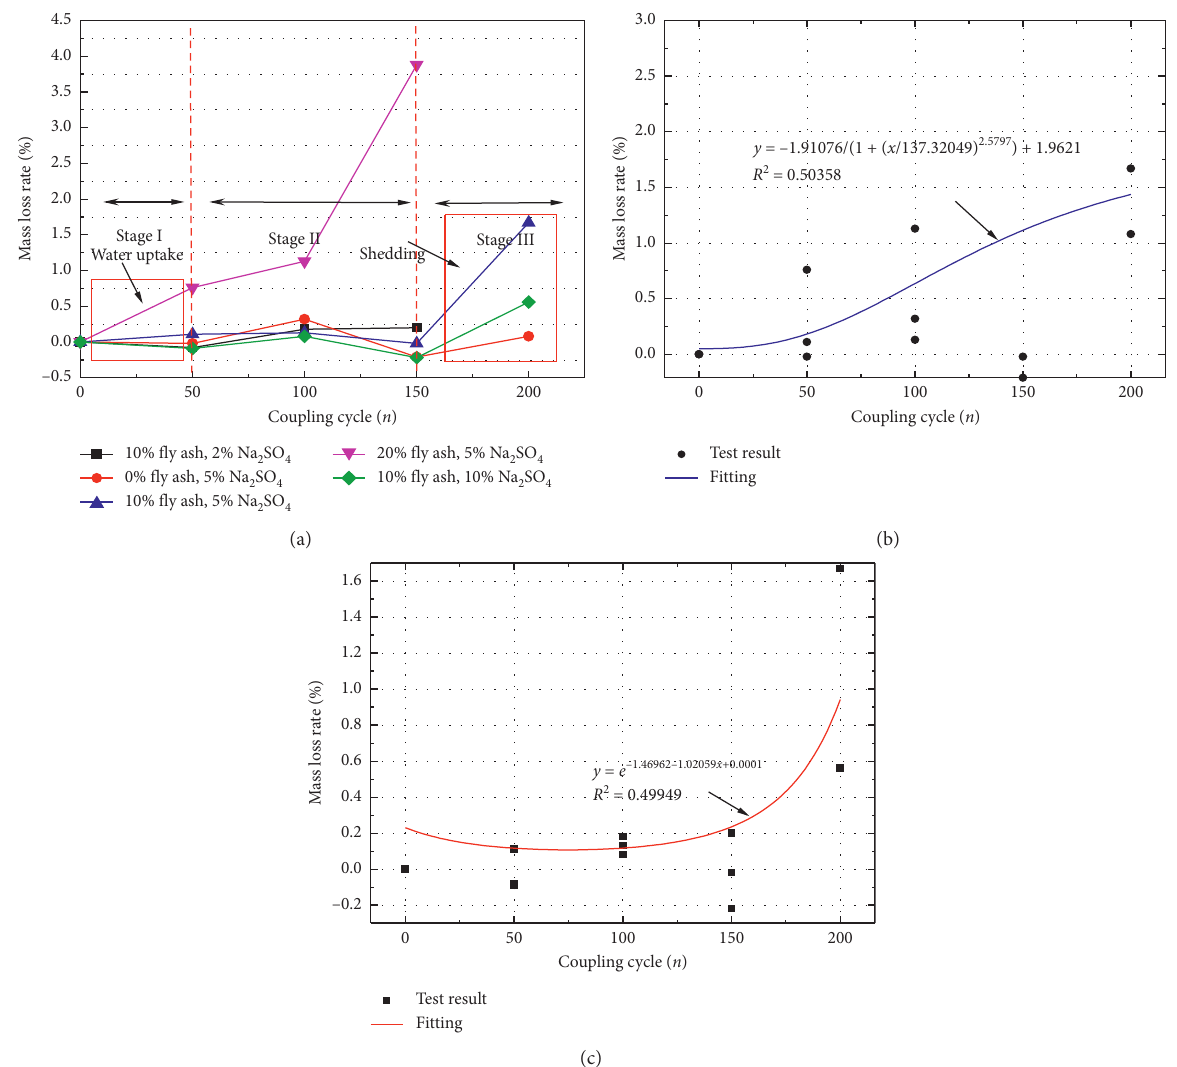
Figure 3: The relationship between mass loss rate and coupling